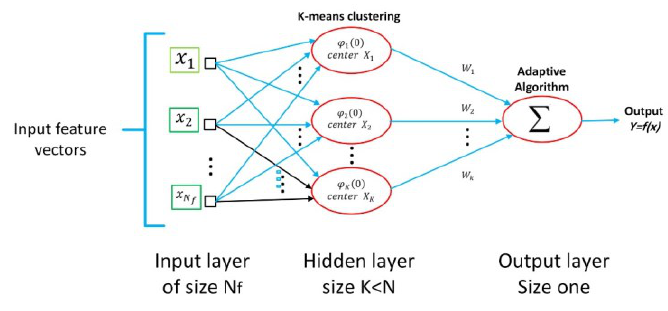
Fig. 9. The proposed hybrid RBF